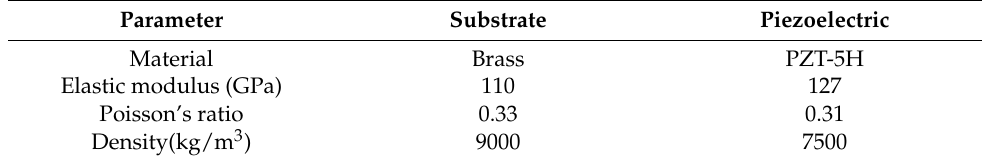
Table 1. Material